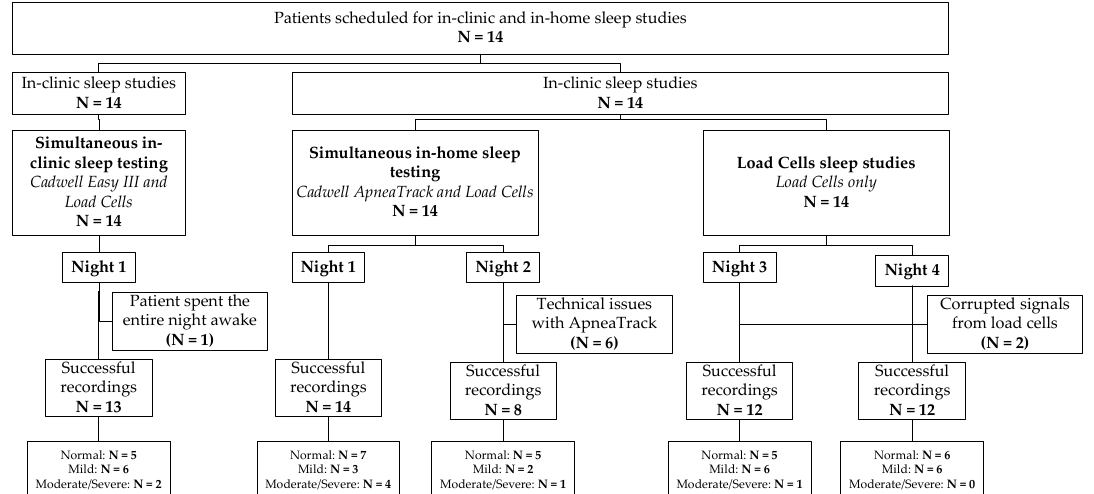
Figure 1. Flow chart of patients who underwent sleep